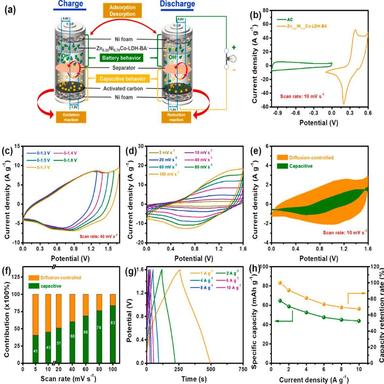
(a) Structural schematic of the Zn0.25Ni0.75Co-LDH-BA– //AC supercapattery. (b) CV curves of the Zn0.25Ni0.75Co-LDH-BA– and AC electrodes at 10 mV s − 1 . (c) CV curves at the sweep rate of 40 mV s − 1 of the device in varied potential windows. (d) CV curves of the device with the potential sweep rate varied from 5 to 100 mV s − 1 . (e) CV partition analysis at 10 mV s − 1 and (f) normalized contribution ratio of capacitive capacities at different scan rates. (g) GCD profiles at different current densities